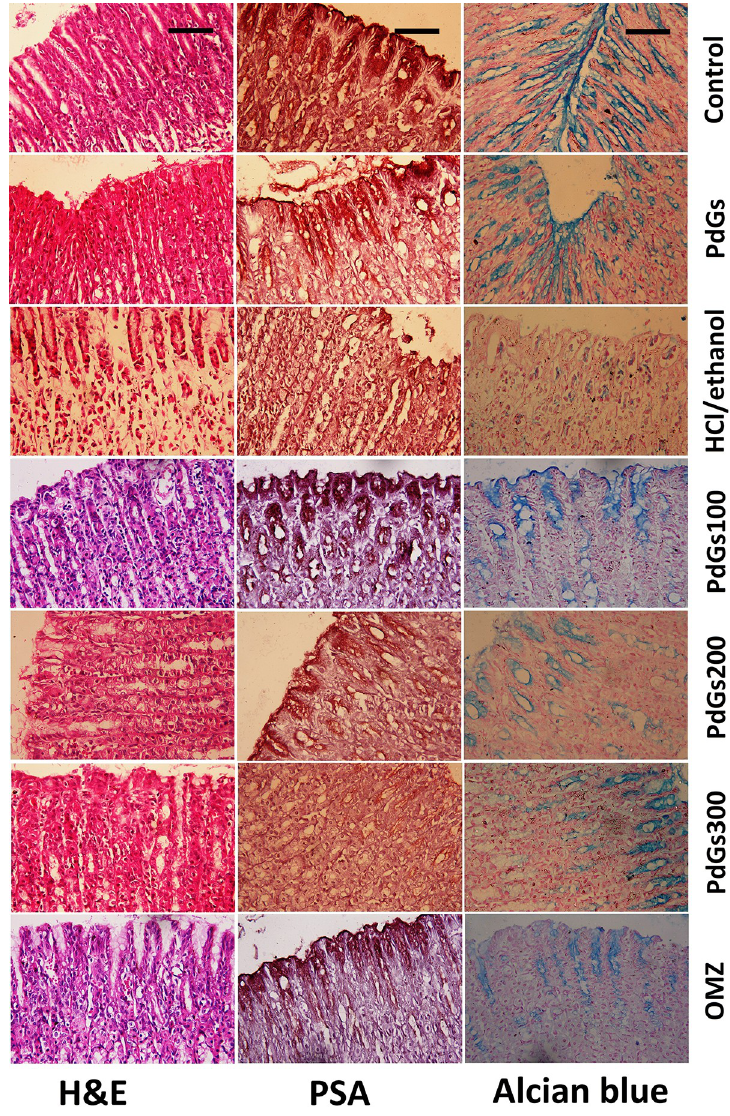
Fig 4. Effect of prodigiosins on histopathological alternation featurs and PAS and alcian blue reactions on HCl/ ethanol-induced gastric injury in rats, where, stomach of control and prodigiosins treated alone rats showed normal structure with high mucous content. While, stomach or rats damaged by HCl/ethanol showed sever mucosal damage and hemorrhage with low mucous content. However, prodigiosins and omeprazole treatments preserved gastric layers and increased markedly mucous content (100 × magnification). Scale bar = 50 μ m.